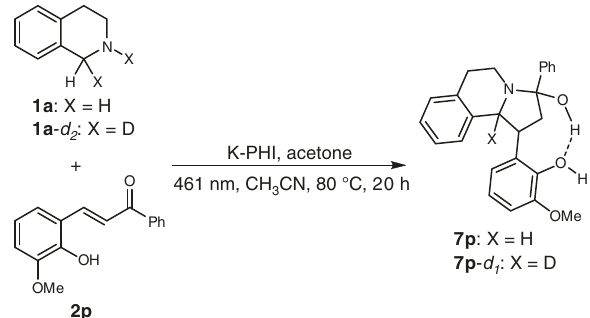
Fig. 3 Synthesis of reduced